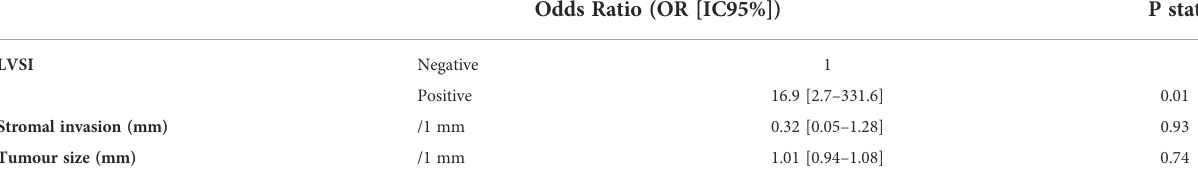
TABLE 2 Odds Ratio analysis of risk factors included in Sedlis Criteria in Senticol 1 and 2 patients.